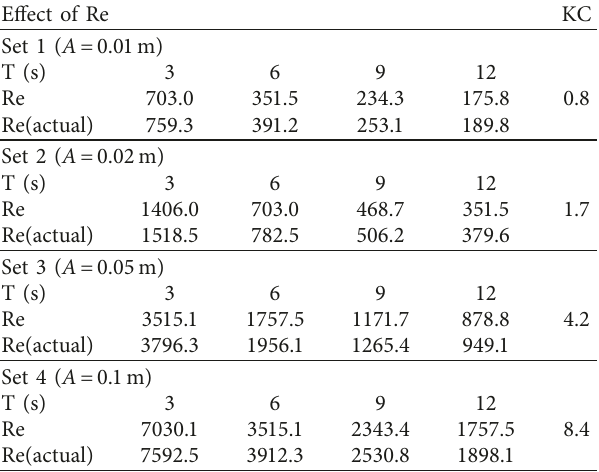
Table 1: Data sets for analysis of effect of Re. Effect of Re